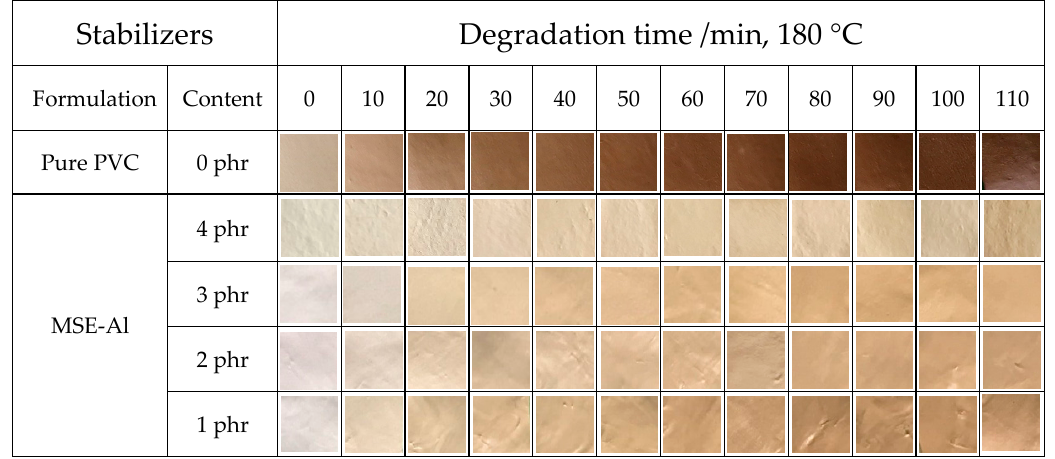
Figure 3. Thermal stability time of the PVC samples stabilized with different amounts of MSE-Al.